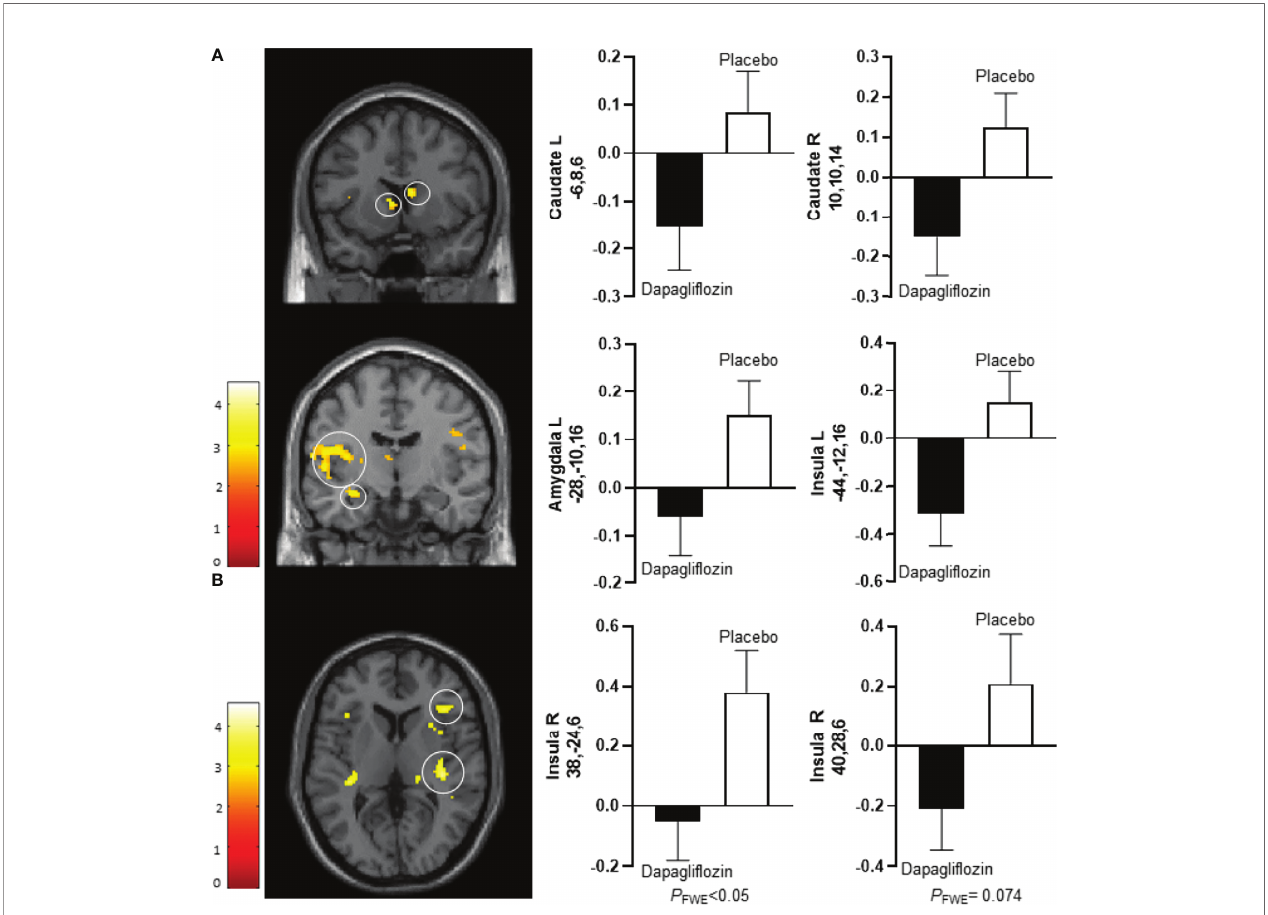
FIGURE 1 | Average differences in CNS activation between dapagli fl ozin (black bar) and placebo (white bar). (A) Axial slice showing average differences between dapagli fl ozin (black bar) and placebo (white bar) after 10 days of treatment in the left caudate nucleus ( P FWE < 0.05, T = 3.7) (upper left panel), the right caudate nucleus ( P FWE < 0.05, T = 3.5) (upper right panel), the left amygdala ( P FWE < 0.05, T = 3.1) (middle left panel), and the left insula ( P FWE < 0.05, T = 3.6) (middle right panel) in response to the viewing of low-calorie versus non-food pictures. (B) . Horizontal slice showing average differences between dapagli fl ozin (black bar) and placebo (white bar) after 16 weeks of treatment in the right insula (left panel: P FWE < 0.05, T = 3.5), and non-statistically signi fi cant in the right insula (right panel: P FWE = 0.074, T = 3.2) in response to the viewing of low-calorie food pictures versus non-food pictures. The left side of the brain slices is the left side of the brain. The color scale re fl ects the T value of the functional activity. Results are presented at the threshold of P < 0.05, familywise error (FWE) corrected on cluster extent within the regions of interest using small volume correction (10 mm sphere; 5 mm sphere for the amygdala). In the graphs, blood oxygen level-dependent (BOLD) signal intensity (effect size) is plotted (arbitrary unites), mean and SEM. The numbers on the y-axes of the bar graphs are the x,y,z, coordinates of the peak voxel of the observed difference in Montreal Neurological Institute (MNI) space. R, right; L,